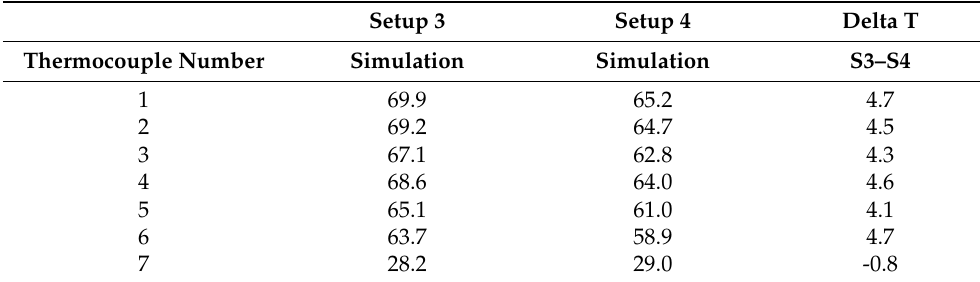
Table 10. Simulations temperature for Setup 3 and Setup 4.